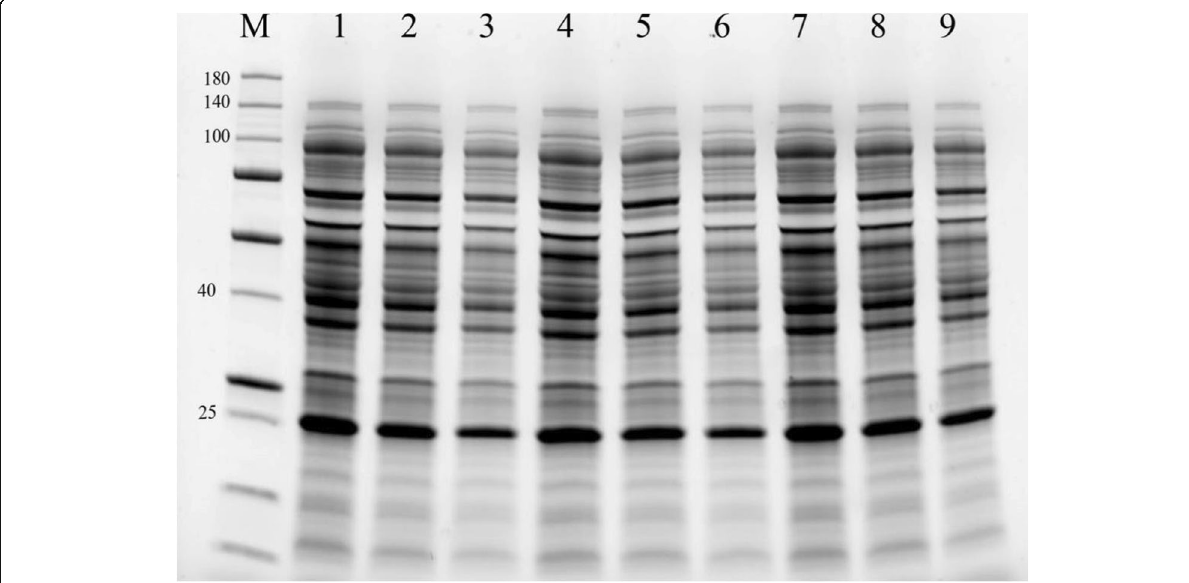
Fig. 4 SDS PAGE profiles of total proteins from 5 alfalfa varieties, 3 ecotypes, and control ( M . truncatula ). M, marker (kDa); 1: M . truncatula ,